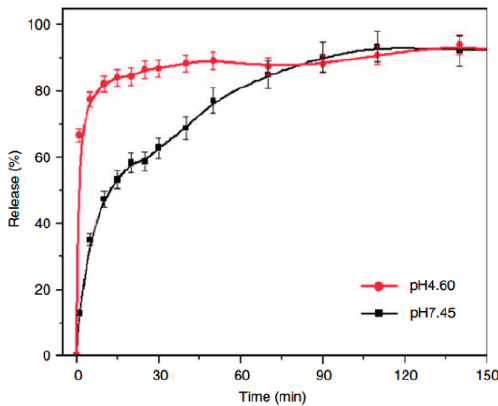
Figure 5. Release profiles of Cpl from Cpl–LDH in buffer solutions at different pH values Reprinted with permission from [58] (Copyright 2006 Elsevier).